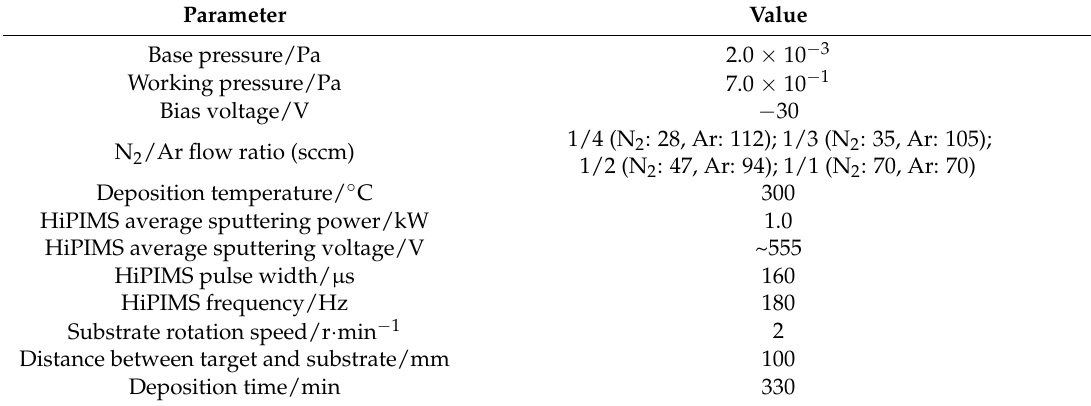
Table 1. Detailed deposition parameters of the Al-Cr-Si-N coatings deposited by